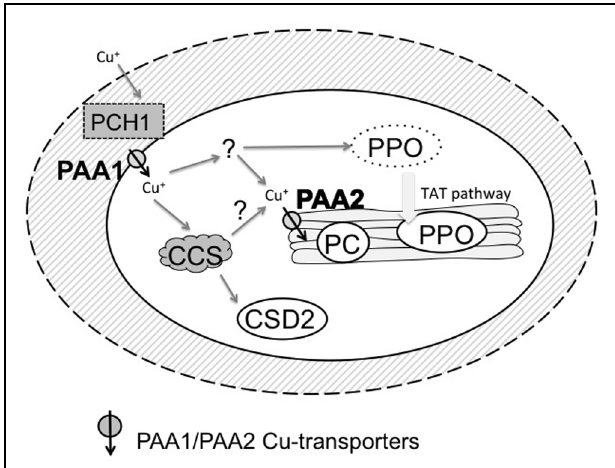
FIGURE 1 | Chloroplast copper proteins and delivery systems. CSD2 (copper/zinc superoxide dismutase) is active in the stroma and receives Cu ions from CCS (the copper chaperone for superoxide dismutase). PC is active in the thylakoid lumen. PPO is found in the thylakoid lumen but may receive its Cu ion in the stroma before entering the thylakoid space via the TAT protein translocation pathway. PAA1 is a copper transporter in the envelope required to supply Cu ions to CSD2, PC and presumably also PPO. PAA1 receives Cu ions from the plastid copper chaperone 1 (PCH1). Cu ions may reach PCH1 in the inter membrane space of the envelope via diffusion through porins in the outer membrane, perhaps bound to low molecular weight chelators such as glutathione. Alternatively, PCH1 might pick up Cu ions in the cytosol and diffuse in via pores in the outer membrane. PAA2 is a homologs copper transporter in the thylakoid membrane required to deliver Cu ions to PC. A protein donating Cu ions to PAA2 has not been identified